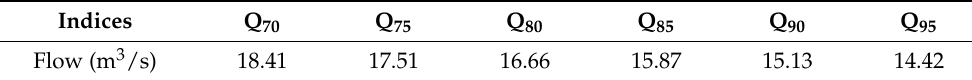
Table 5. Flow duration indices of the Kor